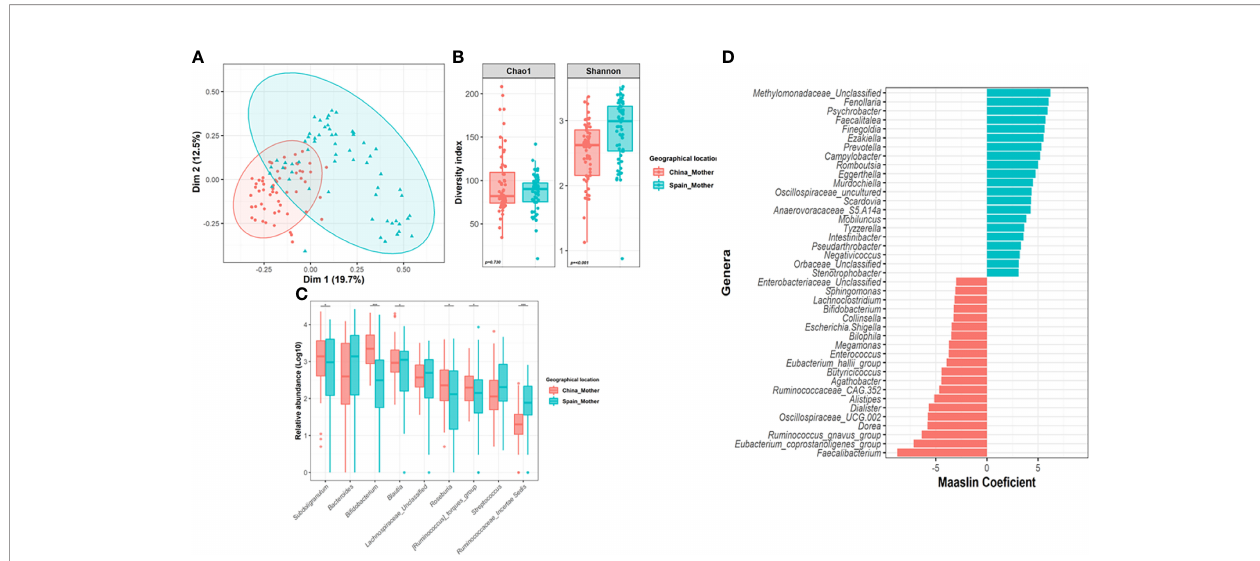
FIGURE 2 | Impact of geographical location on the maternal gut microbiota. (A) Principal Co-ordinates Analysis (PCoA) analysis based on Bray-Curtis distance at genus level according to location. (B) Differences in alpha-diversity of the maternal microbiota (Shannon and Chao1 index) according to location. Signi fi cance of the differences were assessed by Mann-Whitney test. (C) Comparison of core genera relative abundance between mothers from both locations. Signi fi cance was assessed by Mann-Whitney test after centered log ration transformation (CLR). Microbiota data were transformed to log10-values for plotting. (D) Results from the multivariate Maaslin2 analysis showing the differences in terms of microbial composition according to location adjusted by maternal age and body mass index. Only those genera that appeared more than 3 times in at least 10% of samples were included in the analysis. To facilitate the visualization, only those genera with a coef fi cient higher than 3 was plotted (complete list in Table S2 ). (* P < 0.05; *** P <